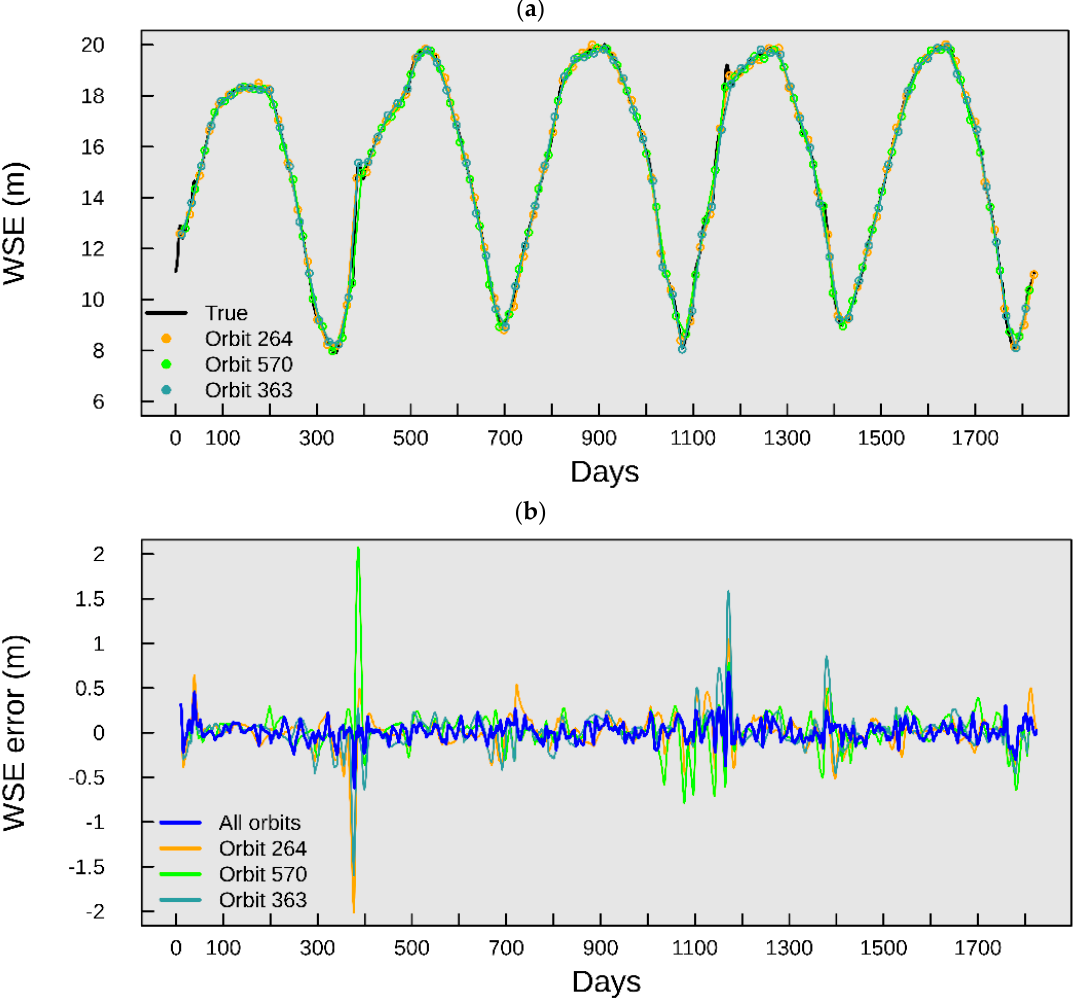
Figure 6. Water surface elevation ( a ) and anomalies ( b ) simulated for the Orient lake, considering three orbits separately and together, in the period 2003–2007.